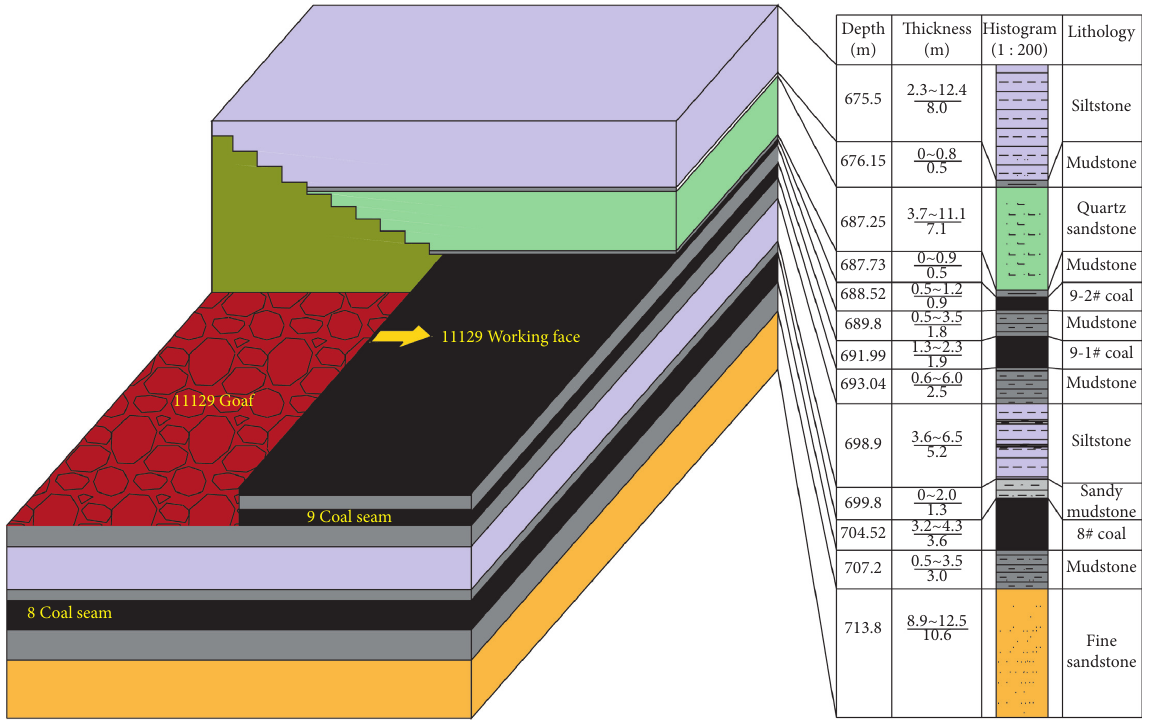
Figure 1: Comprehensive histogram of Zhangji mine’s mining face.